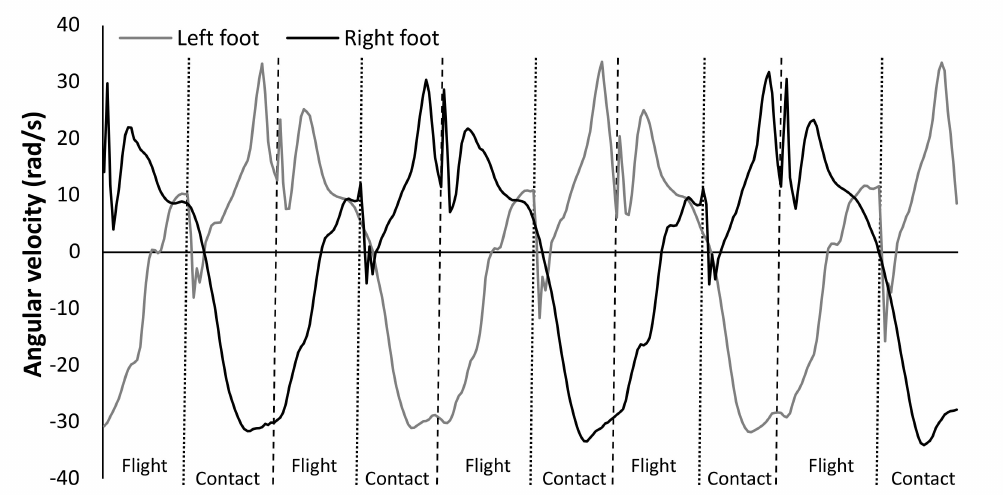
Figure 1. A typical example of five steps of the raw plantar flexion pattern measured with an IMU (Xsens system) attached on the left and right foot with corresponding contact and flight time